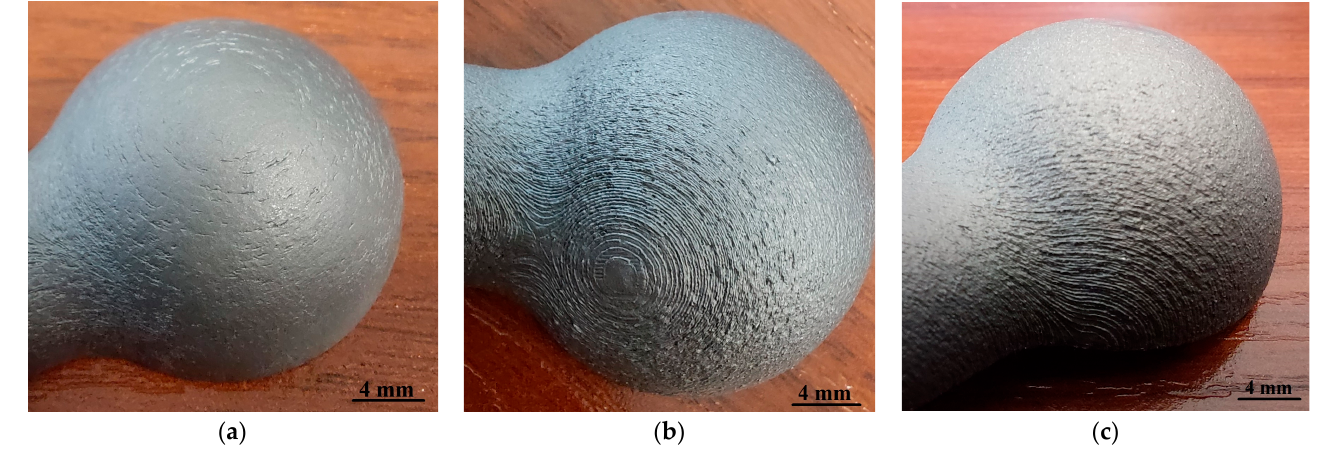
Figure 1. Image of the samples ( a ) 0°, ( b ) 45° and ( c ) 90°. The metrological research was performed using a non-contact, optical profilometer Talysurf CCI Lite (Taylor Hobson, Leicester, UK) with a ×10 lens. The area under analysis included surfaces with dimensions of 1.55 mm × 1.55 mm. The surface under assessment was defined as a sphere with a defined radius equal to 14 mm. In order to assess the distribution variability, five measurements were performed for each placement with respect to the building platform. The measurement surface contained a quadrant of the sphere, which was crucial for mapping the last layer during the building process. The multiscale analysis was carried out with the issue of two-dimensional discrete wavelet transformation and a series of wavelet forms: db2, db12, db20, coif2, coif5, sym2, sym8, bior1.5, bior5.5 and dmey. The particular mother wavelets were selected in order to evaluate their properties as widely as possible in terms of their influence on filtering effects. The exemplary isometric views of the measured surfaces after the removal of the shape are presented in Figure 2.